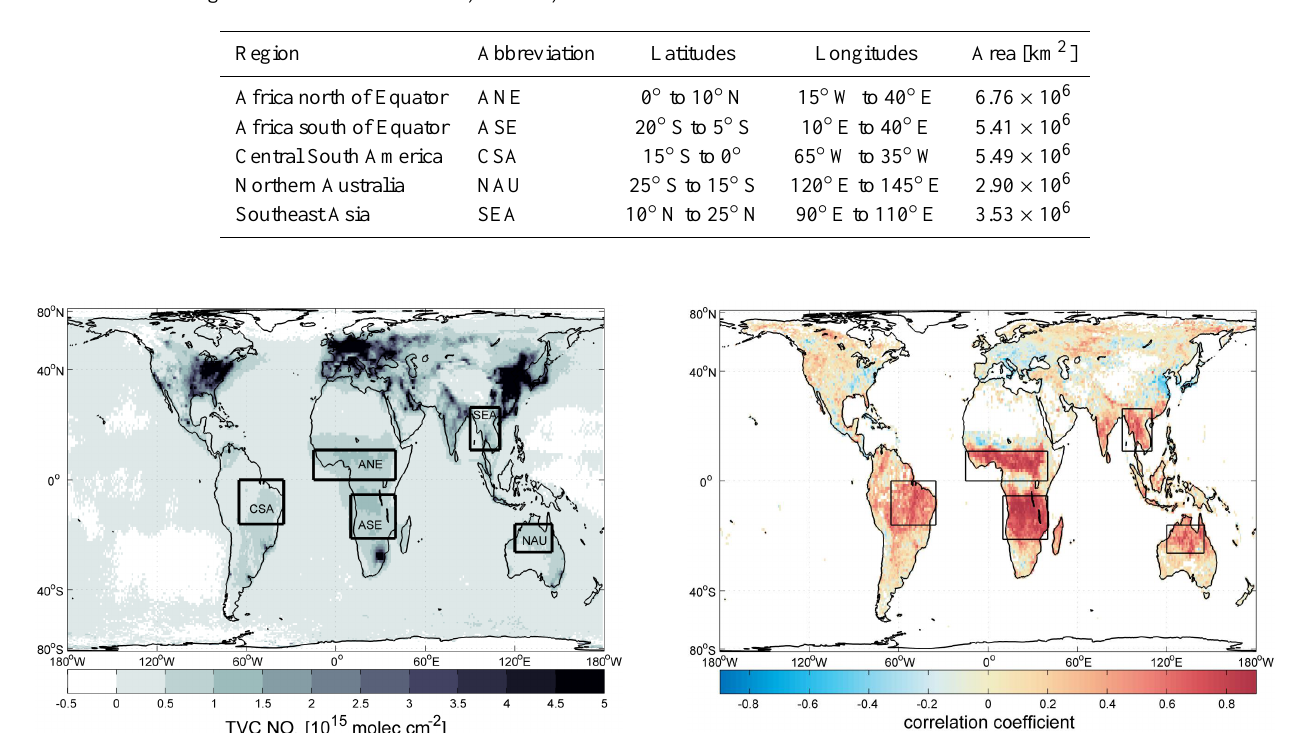
Table 1. Selected regions with their abbreviation, location, and absolute area.